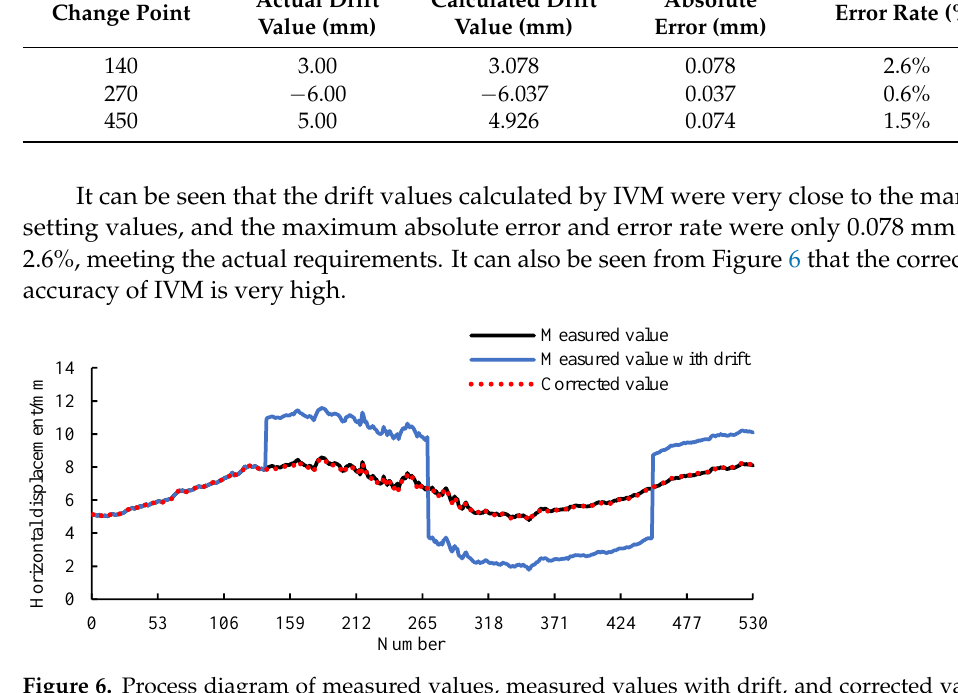
Figure 6. Process diagram of measured values, measured values with drift, and corrected values of PL23-1.